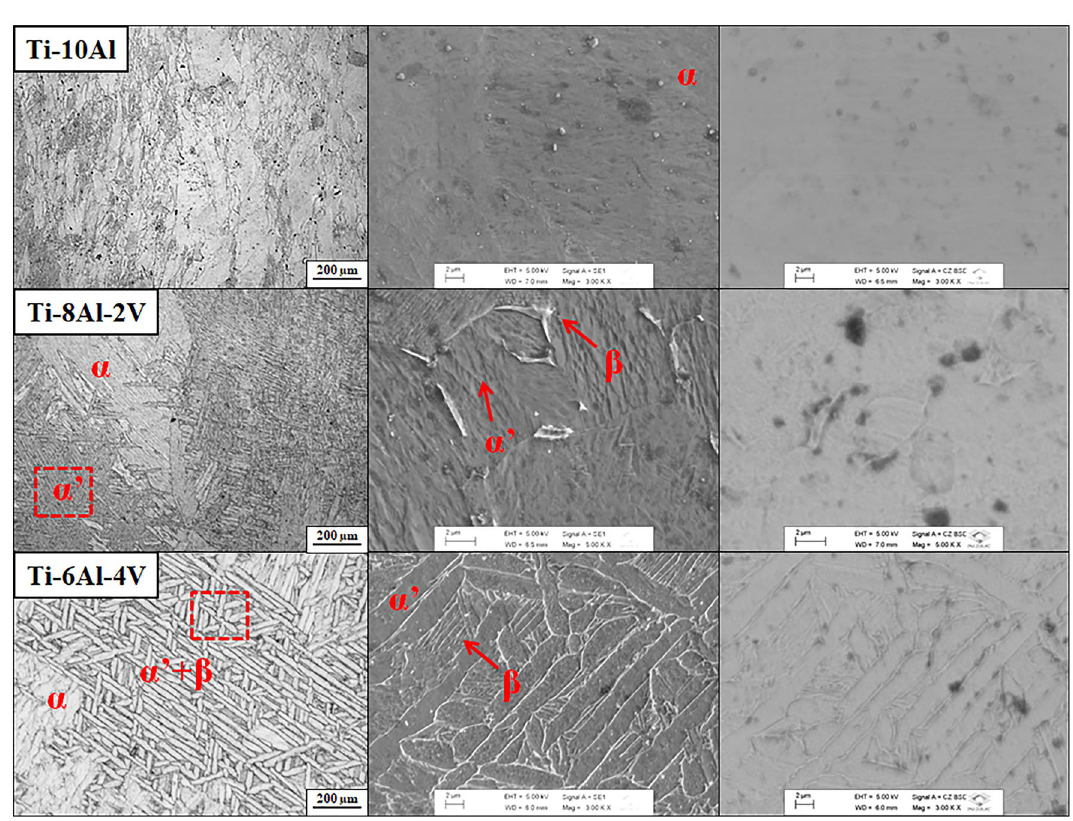
Figure 4. Microstructural analysis: OM (left), SE-SEM (middle), and BSE-SEM (right)